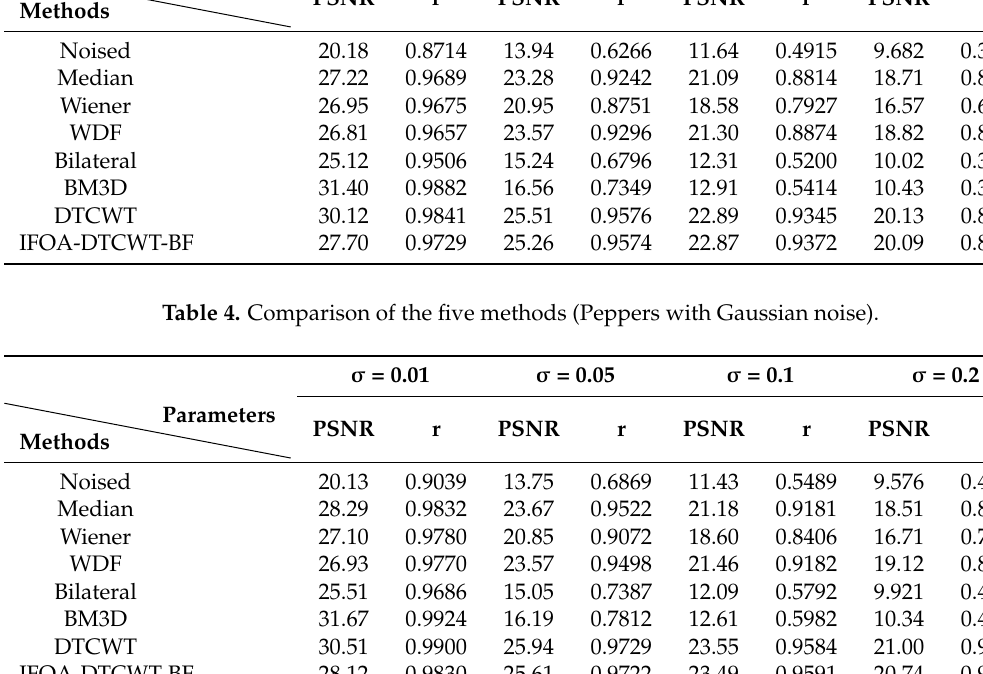
Table 3. Comparison of the five methods (Columbia with Gaussian noise).